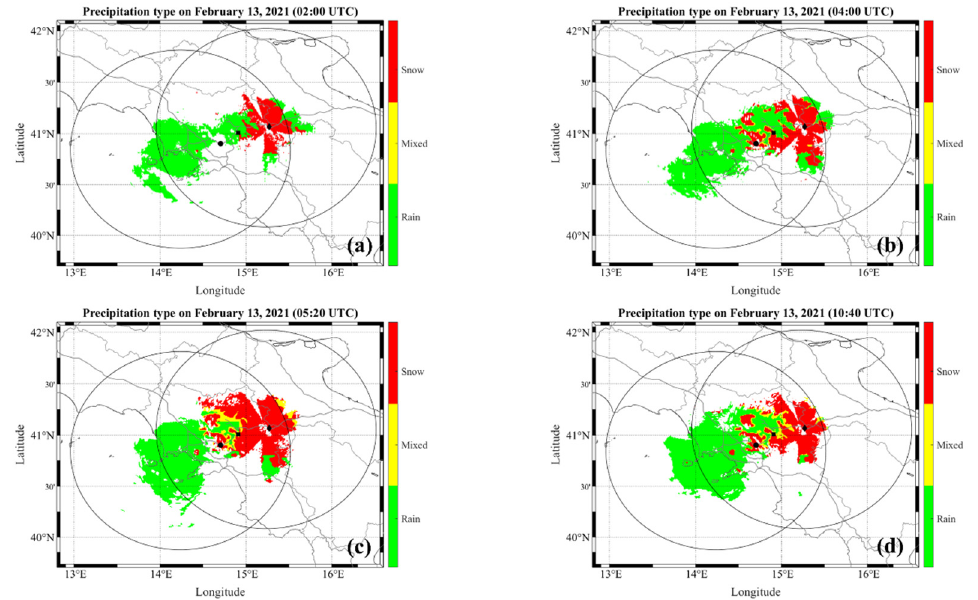
Figure 14. Precipitation type product estimated on 13 February 2021 at 02:00 UTC ( a ), 04:00 UTC ( b ), 05:20 UTC ( c ) and 10:40 UTC ( d ). Each radar composite grid cell is assigned to the rain (in green), mixed (in yellow) or snow (in red) precipitation categories according to the criteria illustrated in Section 3.3. The black markers indicate the three passes located along the A16 highway, i.e., Monteforte Irpino (619 m asl, filled-in circle), Montemiletto (502 m asl, filled-in square) and Scampitella (670 m asl, filled-in diamond). The highways are marked as grey lines, whereas the black circles represent the maximum radar range for the Naples and Trevico radar systems.